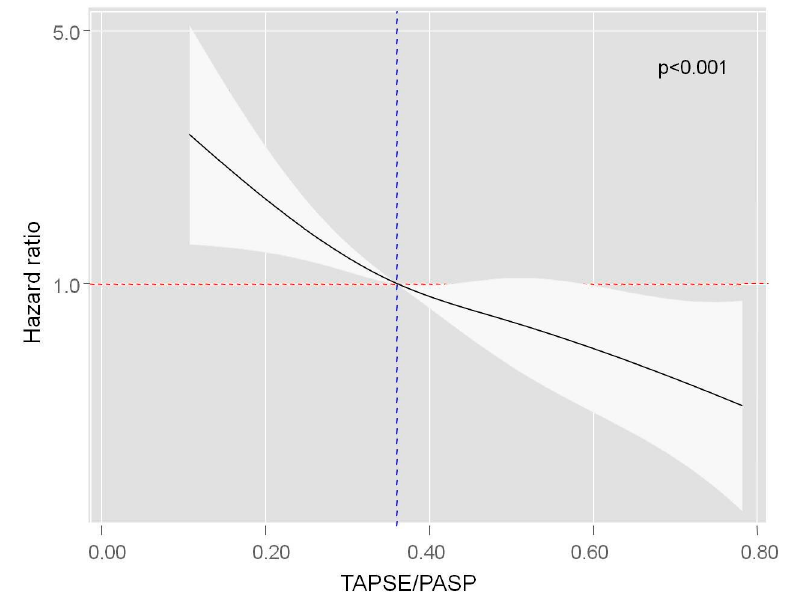
Figure 4. Functional form of TAPSE / PASP ratio evaluated as a continuous variable in the multivariable model for all-cause mortality.